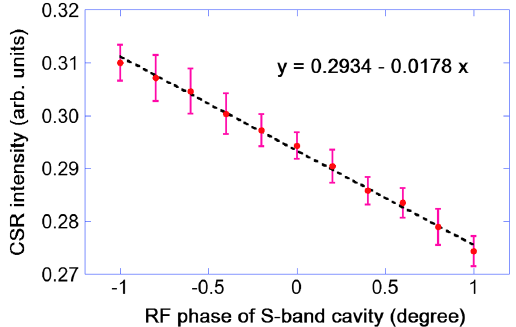
FIG. 23. CSR intensity variation at BC2, dependent on the rf phase change of the S-band accelerating